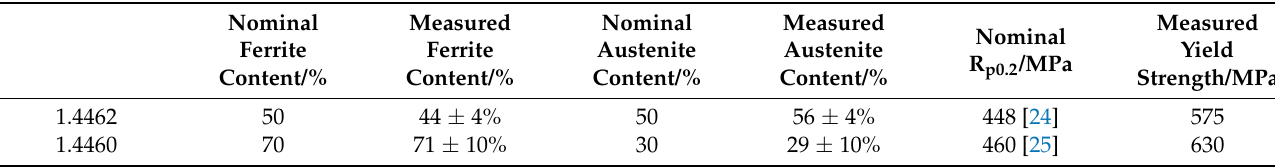
Table 2. Nominal and measured phase fractions and strength values for duplex steels X2CrNiMoN22-5-3 (1.4462) and